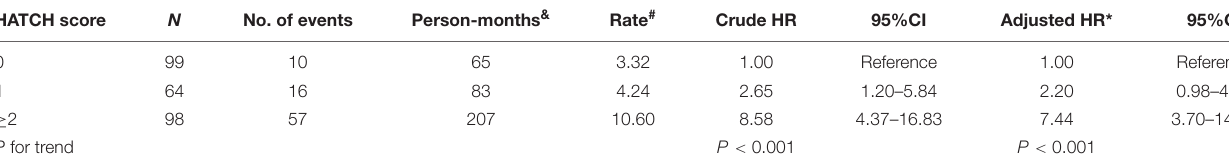
TABLE 3 | Incidence and hazard ratios of atrial fibrillation late recurrence stratified by HATCH score.